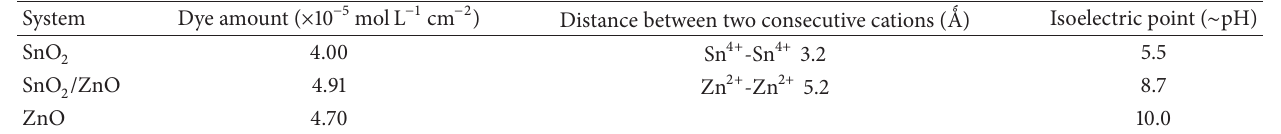
Table 2: Amount of dye adsorbed and bond distances.